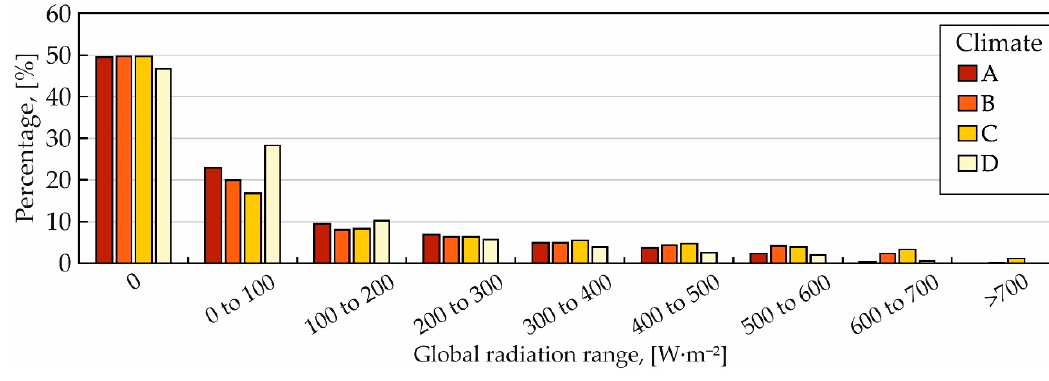
Figure 5. Share of global radiation range for external climates.